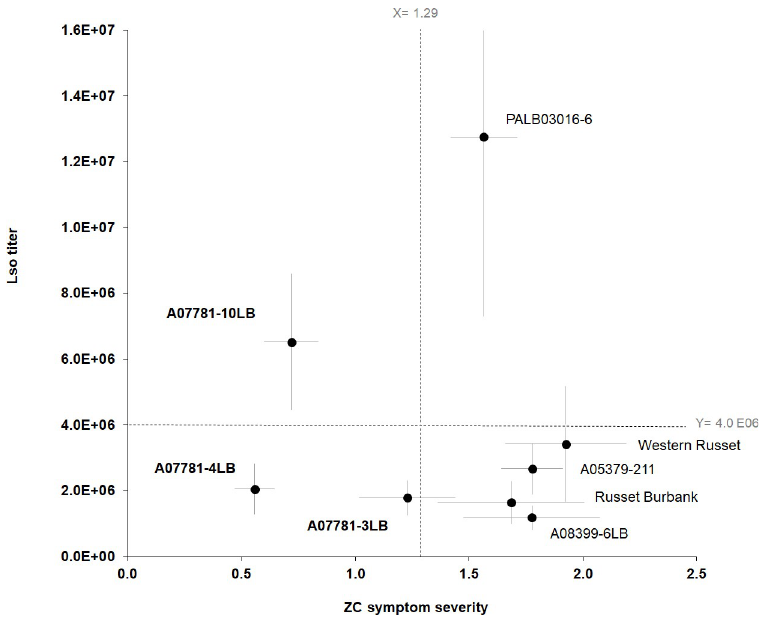
Fig 4. Relationship between Lso titer and ZC symptoms severity of potato genotypes infested at 77 DBVR. Assessments were made in tuber samples at harvest from season 2016 and 2017. Russet Burbank: susceptible control. Two sets of dotted lines represent overall averages of symptom severity and Lso titer across the eight genotypes. Error bars represent standard error ( ± 1).